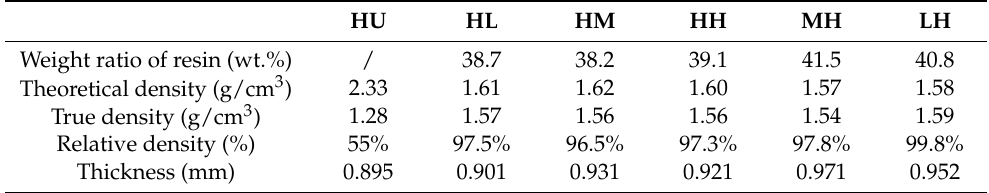
Table 2. Weight ratio of resin, theoretical density, true density, porosity, and thickness of BBPs. HU HL HM HH MH LH Weight ratio of resin (wt.%) / 38.7 38.2 39.1 41.5 40.8 Theoretical density (g/cm 3 ) 2.33 1.61 1.62 1.60 1.57 1.58 True density (g/cm 3 ) 1.28 1.59 Relative density (%) 55% 97.5% 96.5% 97.3% 97.8% 99.8% Thickness (mm) 0.895 0.901 0.931 0.921 0.971